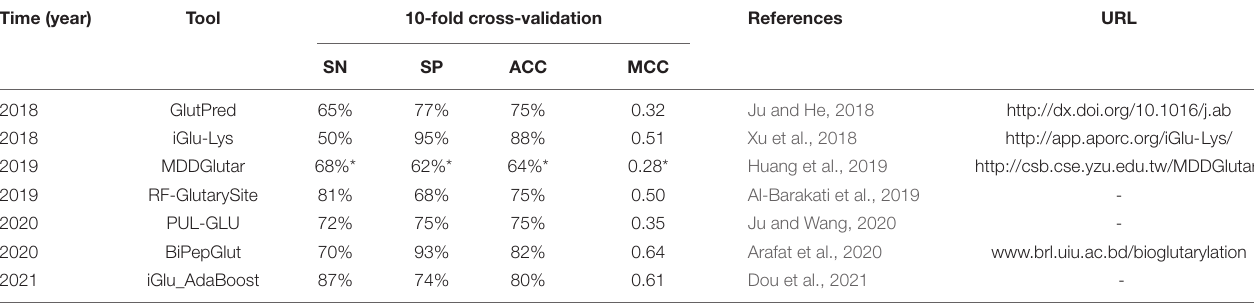
TABLE 2 | Statistics of information on developed site prediction models.